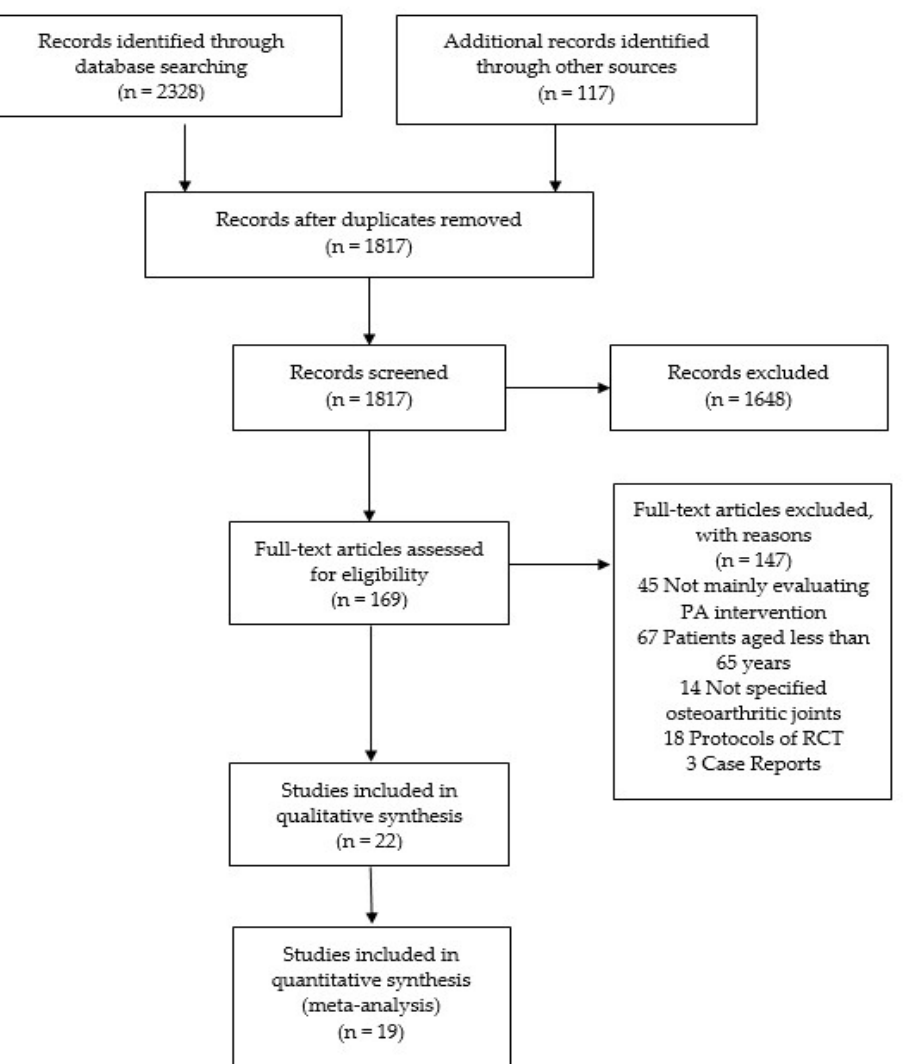
Figure 1. Flowchart of the article selection process.